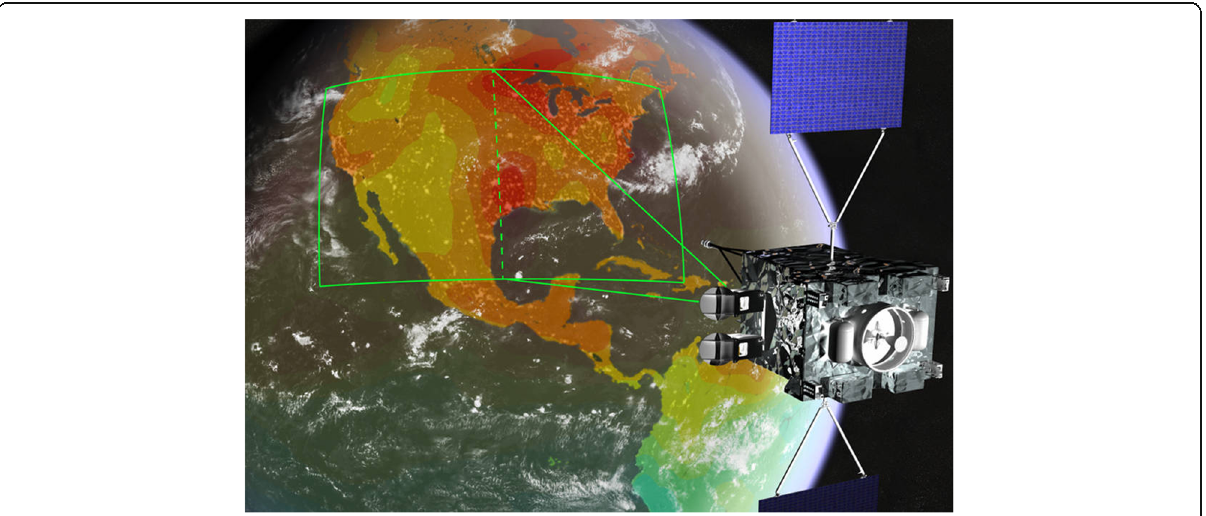
Fig. 25 Artist ’ s rendition of the areal coverage of GeoCARB (Geostationary Carbon Cycle Observatory) being mounted on a commercial geostationary communication satellite operated by SES S.A. GeoCARB will be centered at 85° West longitude over the Americas and will make observations between 50° North and South latitudes. GeoCARB will acquire properties of atmospheric constituents including carbon dioxide, methane, and carbon monoxide at multiple times during the daylight hours, to improve understanding about the global carbon cycle and vegetation health. Figure from